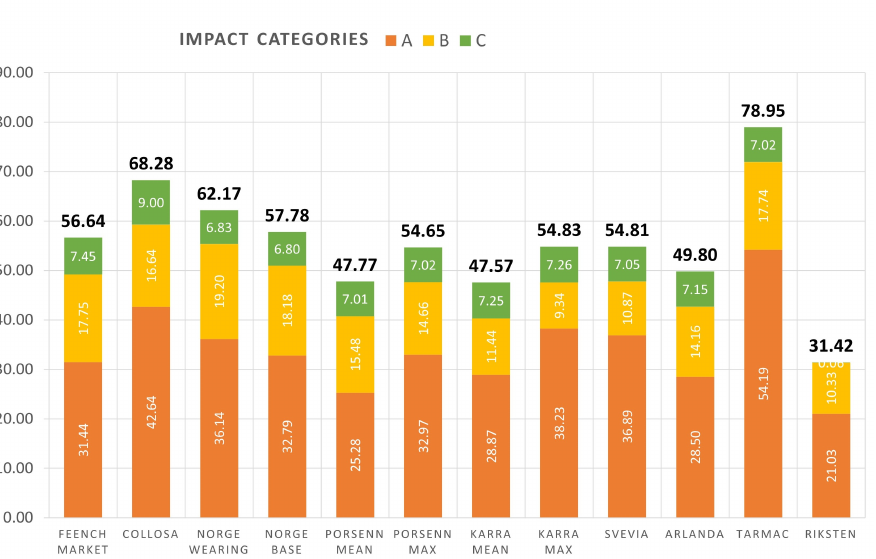
Figure 2. EAR values calculated per certified mixtures. Share related to the each impact category reported with different